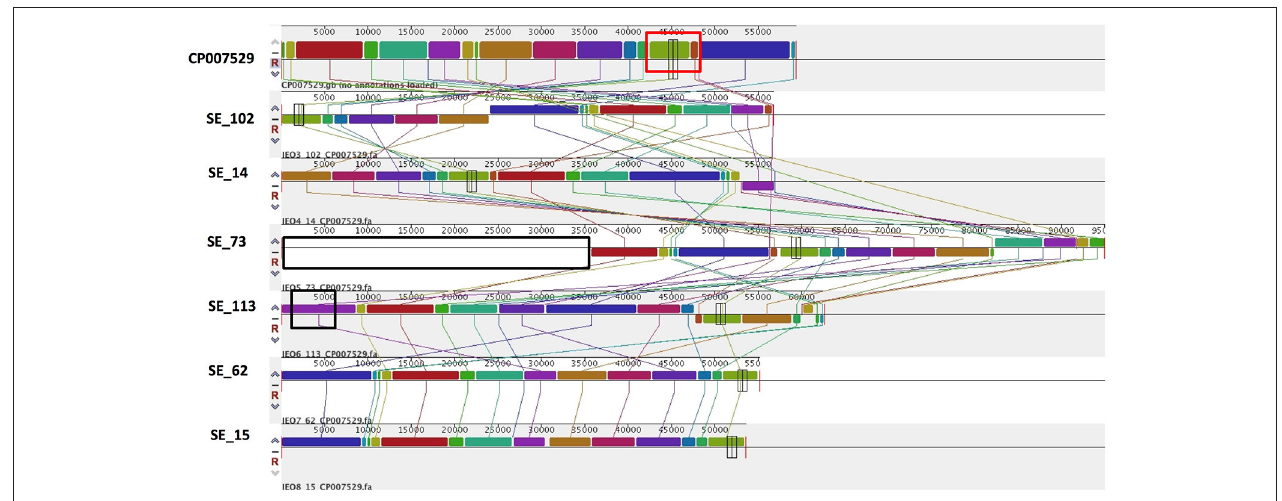
FIGURE 1 | Alignment of IncFII(S)/IncFIB(S) plasmid homologs of Salmonella Enteritidis to a reference plasmid CP007529. The alignment was created with MAUVE. Top row shows the reference plasmid, and the rows below the reconstructed plasmids in Salmonella Enteritidis from the study. Each of the colored blocks outlines a region of the genome sequence that aligned to part of another genome, and is presumably homologous. Areas with no blocks were not aligned and contain sequence elements specific to a particular genome. The red box indicates the spv virulence- associated region in the reference plasmid. Black boxes surrounding a block in SE_113 and in SE_73 indicate antibiotic resistance gene blaTEM- 1 and predicted IncN plasmid incorporation, respectively.